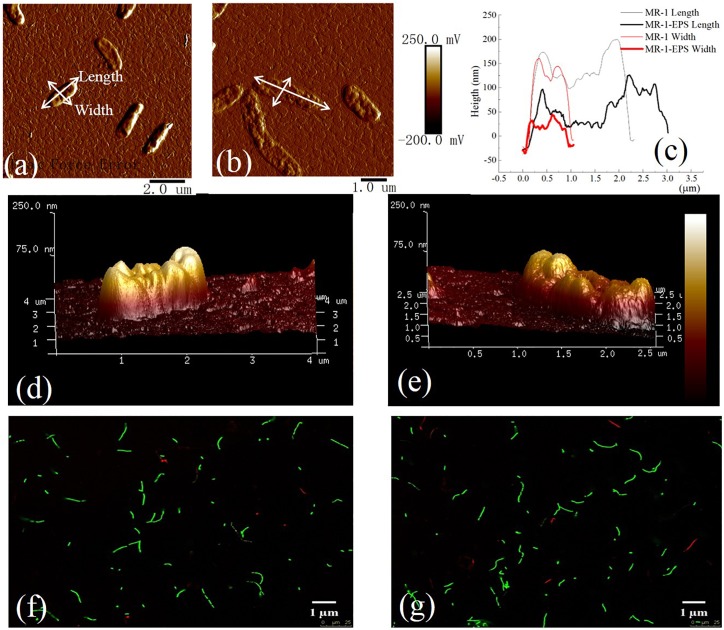
AFM images of MR-1 cell with EPS (a,d) and without EPS (b,e). Height of cells in length and width for MR-1 cell with EPS and without EPS (c) [Text with white leader in (a,b)]. LIVE/DEAD staining of MR-1cells with EPS (f) and without EPS (g). Excitation wavelength of 488 nm and an emission wavelength of 503 nm for SYTO 9 (green) and at 543 nm excitation collected at 605 nm for propidium iodide (red) on the 40x objective lens. The cell viability was detected by staining with SYTO 9 (green) (excitation/emission: 488/503 nm) and propidium iodide (red) (excitation/emission: 543/605 nm).